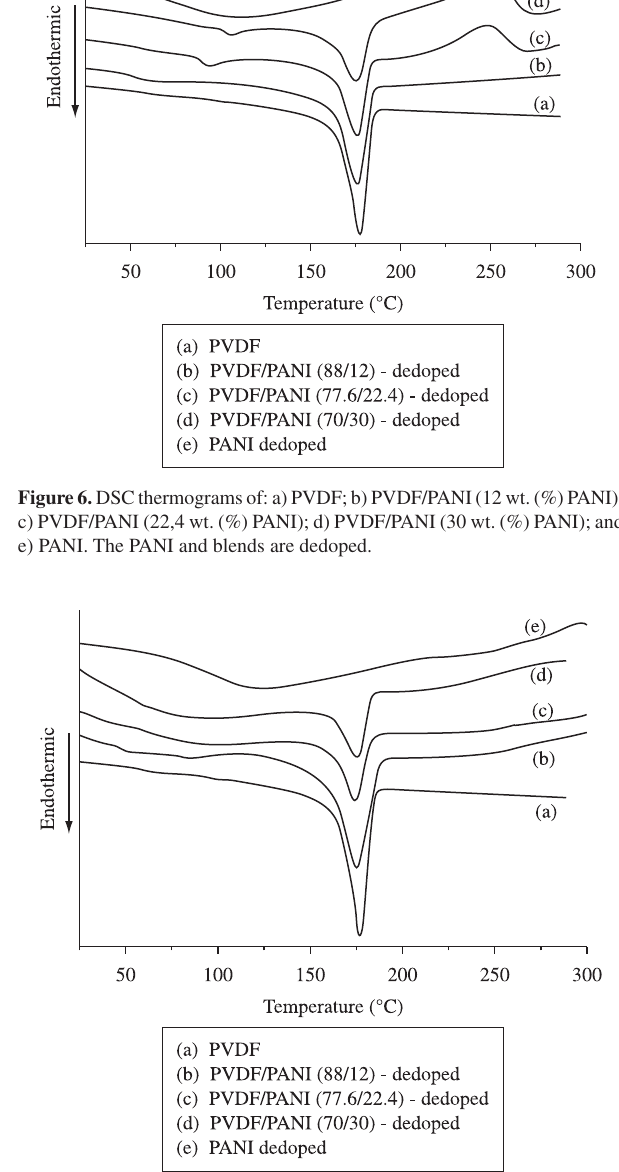
Figure 7. DSC thermograms of: a) PVDF; b) PVDF/PANI (12 wt. (%) PANI); c) PVDF/PANI (22,4 wt. (%) PANI); d) PVDF/PANI (30 wt. (%) PANI); and e) PANI. The PANI and blends are redoped with HCl-1.0